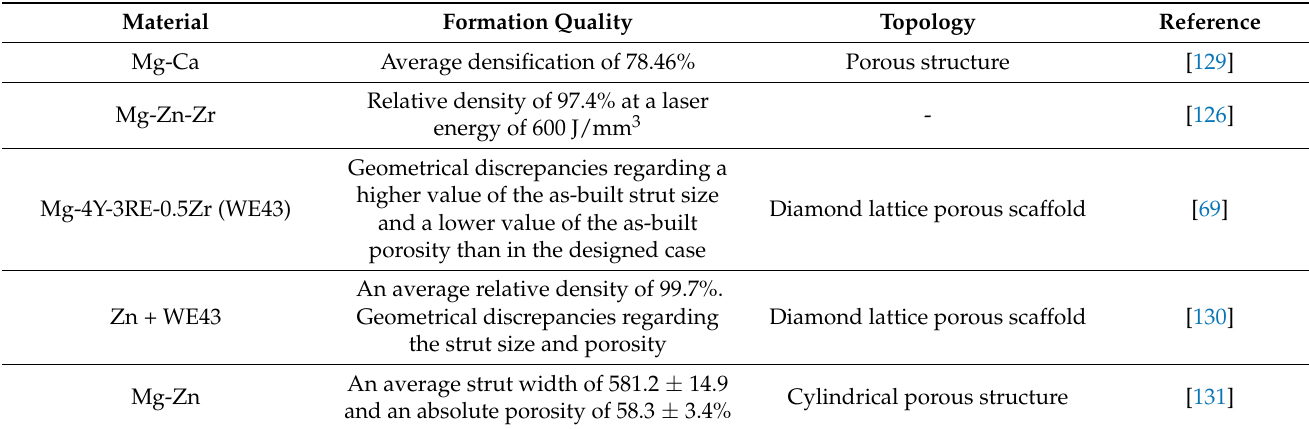
Table 5. Formation quality of additively manufactured Mg-based porous materials and